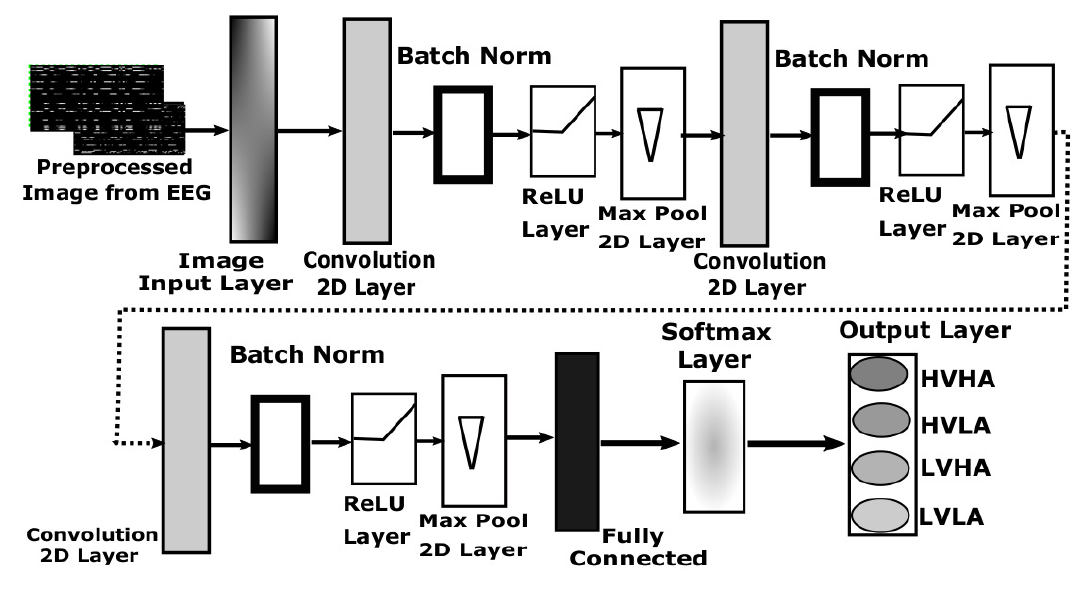
Figure 6. Design of deep neural network (2D-CNN) for EEG-based image data.